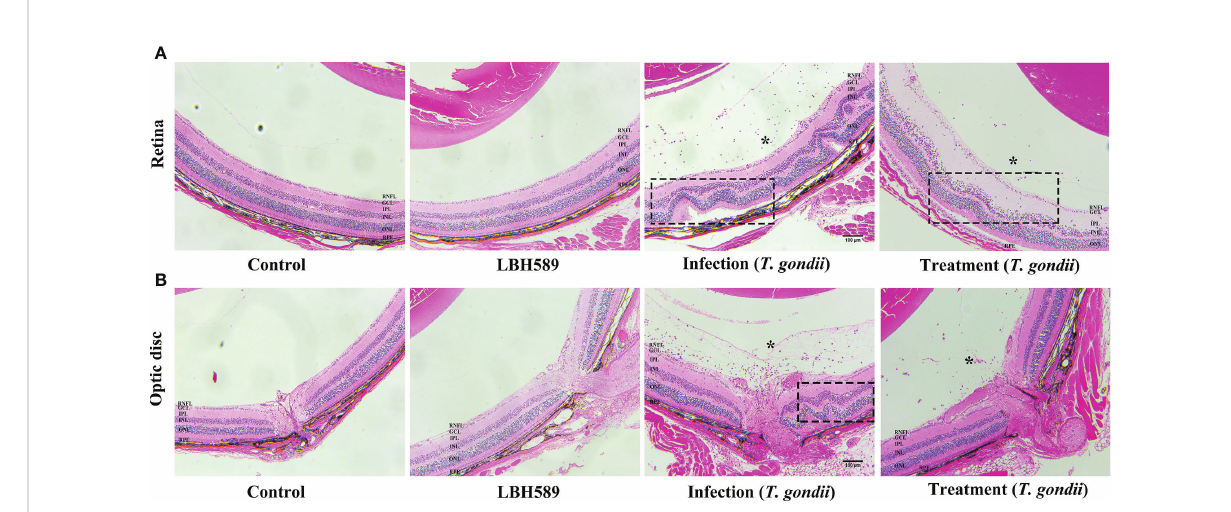
FIGURE 6 Histological changes of mice eyes. Compared with the control, histological retinal (A) and optic disc (B) changes in the eyes of LBH589-injected, tachyzoites-infected and LBH589-treated mice at 7 dpi such as in fl ammatory cell in fi ltrate (asterisk), retinal folding and destruction of retinal architecture (black rectangle). The retinal structure of normal mice injected with LBH589 alone was not signi fi cantly abnormal compared with the control. Scale bars: (A, B) = 100 m m. Data are representative of results obtained from six mice in each